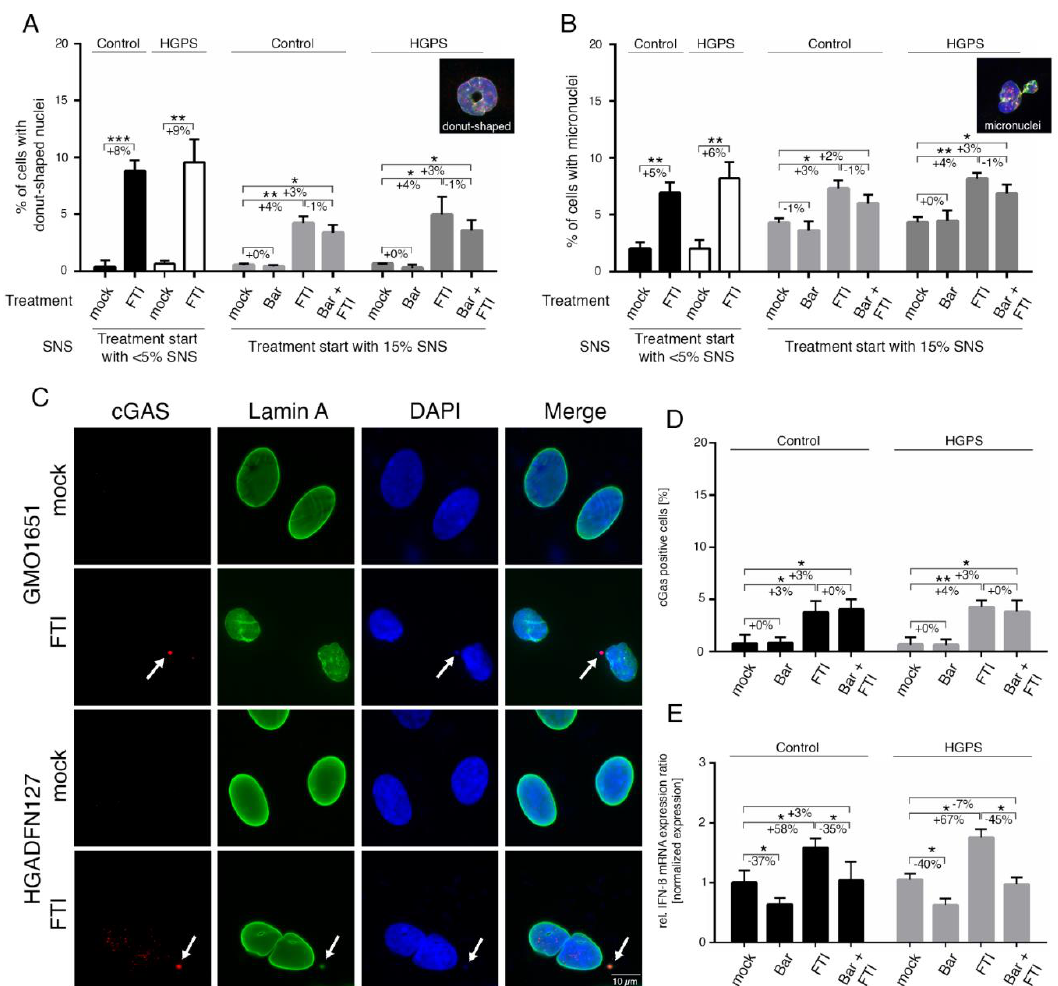
Figure 2. FTI treatment activates the cGAS-STING pathway. ( A ) Determination of the frequency of donut-shaped nuclei with indicated treatment and senescence (SNS). Cells were either treated with vehicle (DMSO), Bar (1 µ M), FTI (0.025 µ M), or combined drugs for a period of nine days. ( B ) Determination of the frequency of micronuclei at indicated treatment and senescence after a period of nine days. ( C ) Representative immunofluorescence images of an HGPS (HGADFN127) fibroblast cell strain treated for nine days as indicated. Antibodies against lamin A (green) and cGAS (red) were used, counterstained with DAPI. Fluorescence images were taken at a 60 × magnification. Scale bar: 10 µ m. ( D ) Percentage of cells positive for cGAS after indicated treatment. ( E ) Quantitative real-time PCR analysis of IFN- β in cells treated as indicated. Relative expression was normalized to expression of GAPDH. Graphs show mean ± SD. Representative images are shown ( n = 3; * p < 0.05, ** p < 0.01, *** p < 0.001).